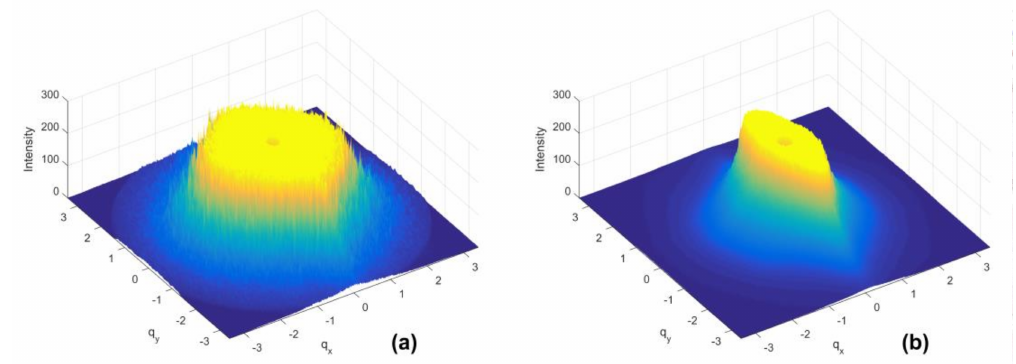
Figure 2. Three-dimensional distribution of light intensity on the scattering vector plane for 2.5% ( w / w ) chitosan solution at 40 ◦ C. ( a ) Data for shear rate 1 s − 1 . ( b ) Data for shear rate 500 s − 1